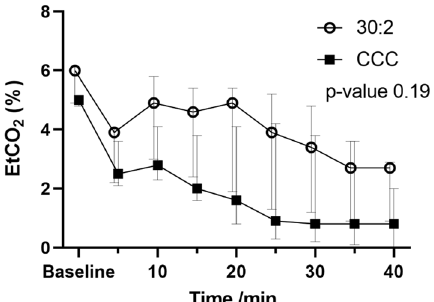
Fig. 4 EtCO 2 levels of the 30:2 and CCC groups during experimental cardiopulmonary resuscitation shown as medians and interquartile ranges. The p - value is given for a linear mixed model between the groups. EtCO 2 : end-tidal carbon dioxide; CCC: continuous chest compressions